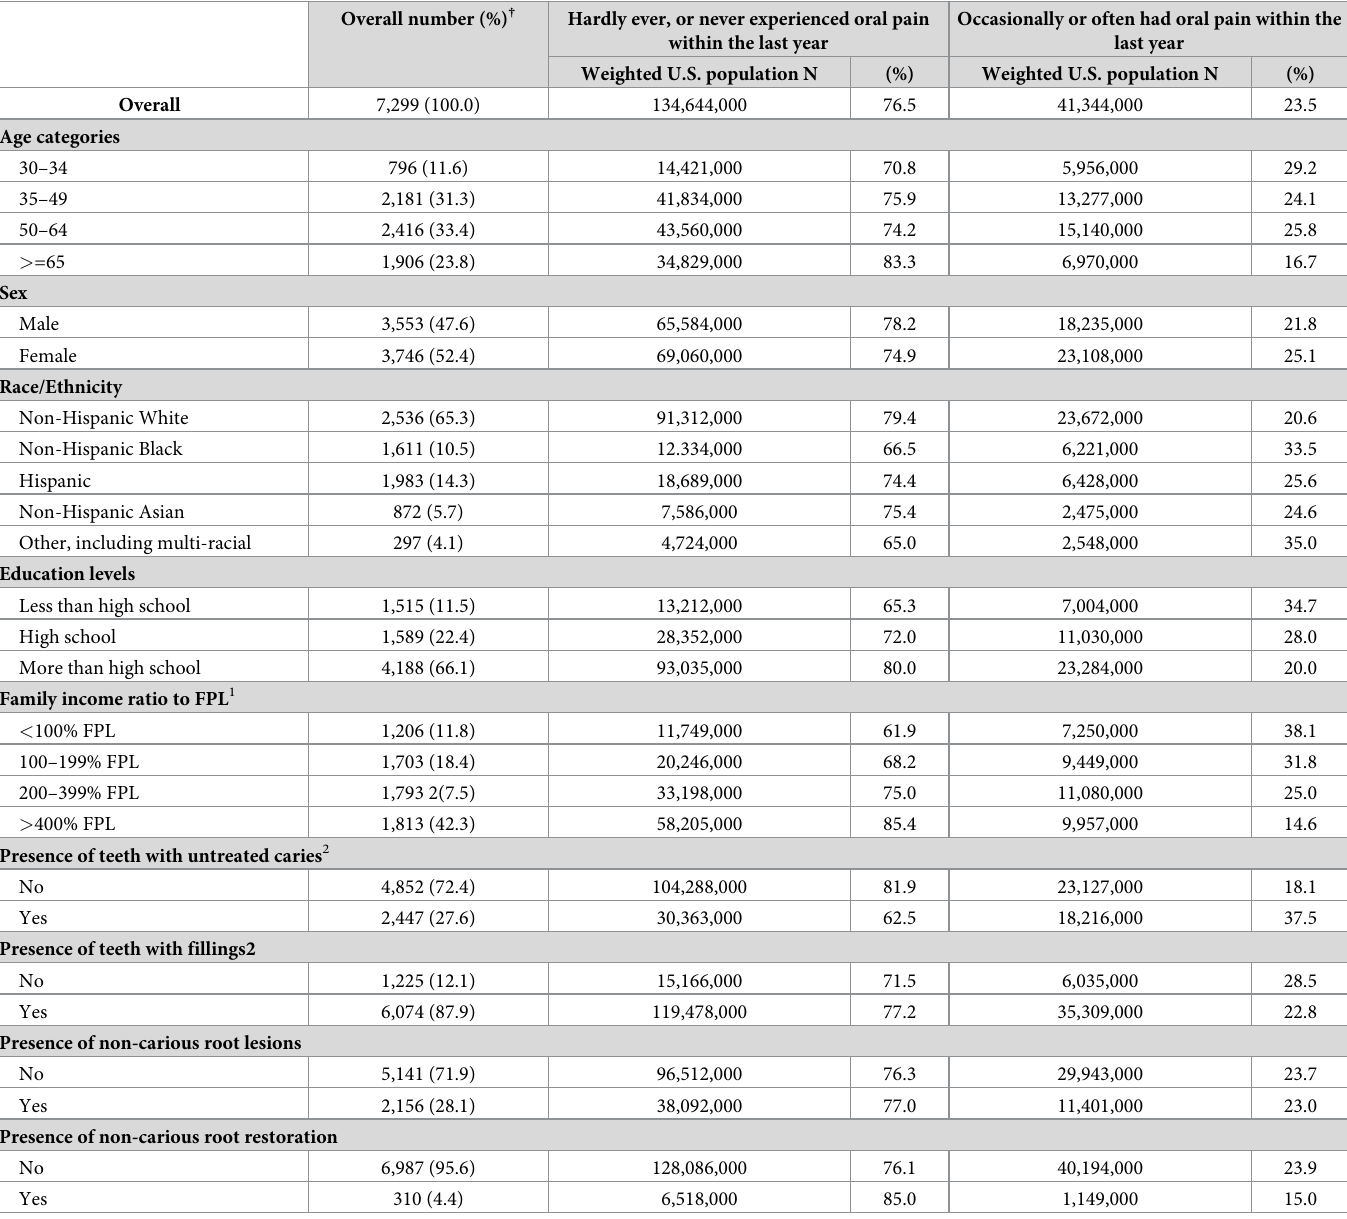
Table 1. Demographics and prevalence of oral pain among adults aged � 30 years who completed the dental examination and at least the first 24-hour dietary recall interview, had at least one natural tooth, and provided an answer about their oral pain experience in the National Health and Nutrition and Examination Survey (NHANES);